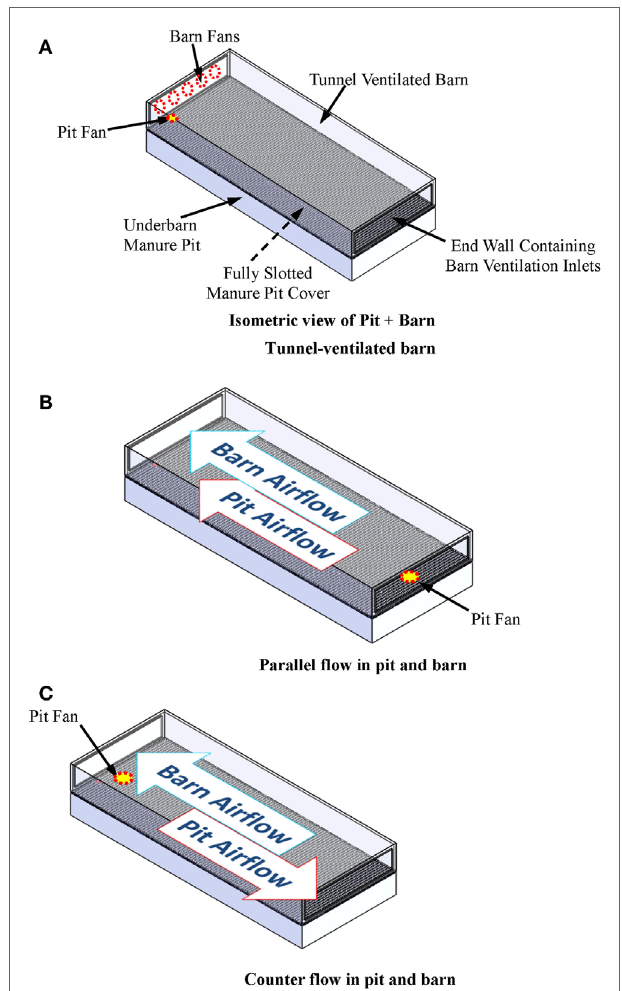
FIgURe 2 | (A) Definition sketch of a slotted-covered manure pit beneath a tunnel-ventilated barn; (B) parallel flow in tunnel-ventilated pit + barn; and (c) counter flow in tunnel-ventilated pit + barn.